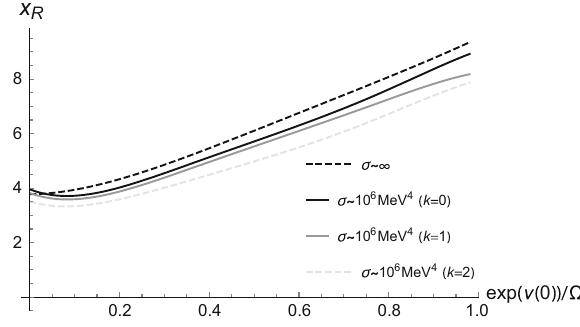
Fig. 1 Dark SU( N ) EMGD star mass M ( x R ) , normalized by ν ( 0 ) with respect to e (cid:9) 2 . The black line regards the GR limit other lines depict the phenomenological bound for the brane tension σ (cid:2) 3 . 18 × 10 − 6 GeV 4 : the standard MGD procedure is a particular case of the EMGD for k = 0 (gray line); the EMGD case is plot for k = 1 (black dashed line) and for k = 2 (gray dashed line)